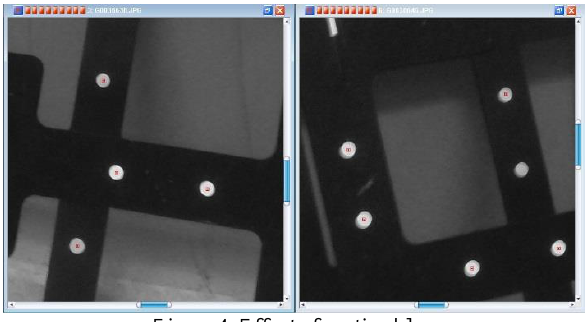
Figure 4. Effect of motion